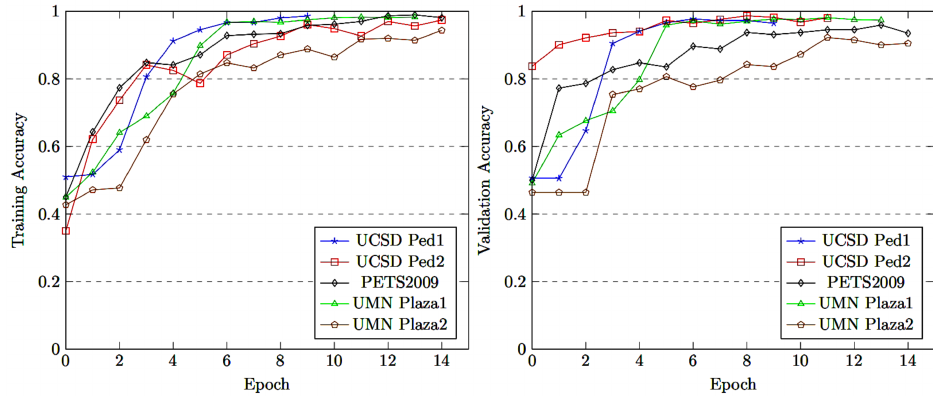
Figure 5. Training and validation accuracy of MCMS-BCNN-Attention + densenet121.